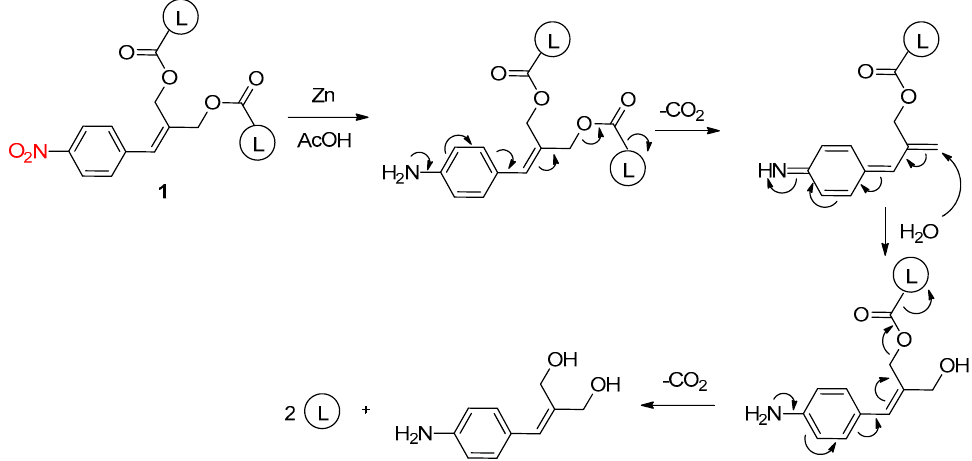
Scheme 2. Structure of double-release compound 1 and proposed mechanism of liberation of two leaving groups L after chemical activation of 1